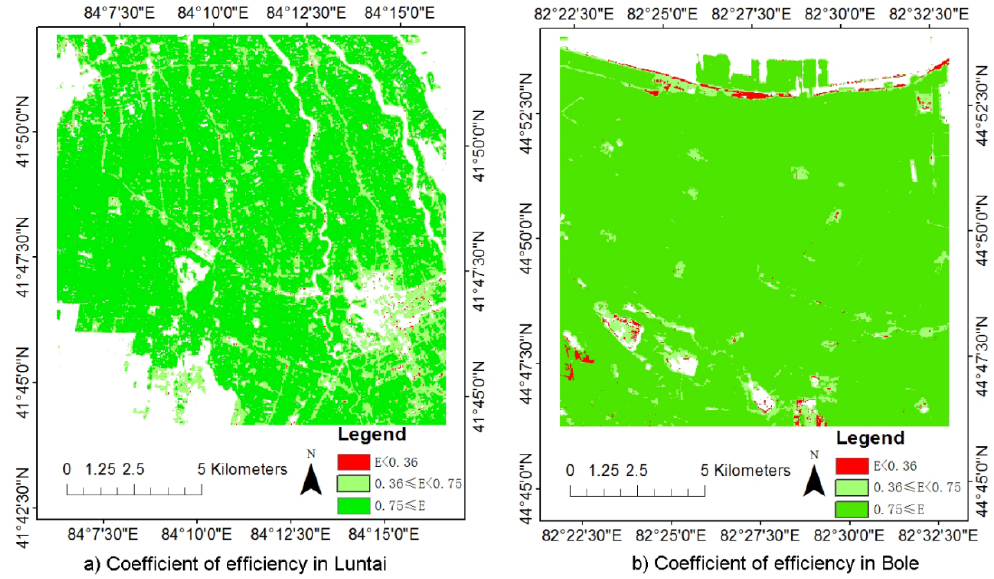
Figure 5. Coefficient of efficiency ( E ) values in ( a ) Luntai and ( b ) Bole.